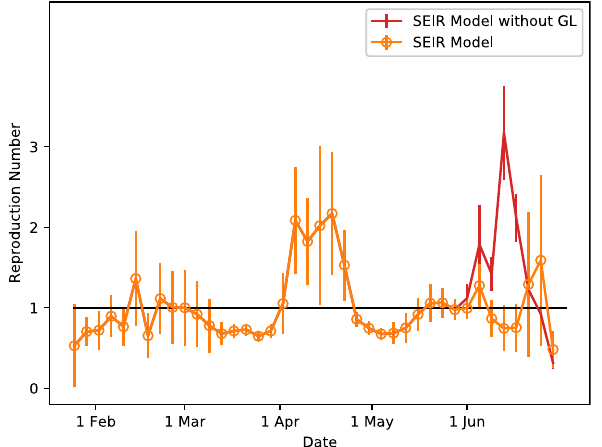
Figure 4. The dynamical evolution of the reproduction number R e derived from the SEIR multiplex model with and without Gradual Lifting (GL) measures. Note that the two very small waves of COVID-19 transmission at 14 Feb 2020 and 22 Feb 2020 discussed in the main text (see Fig. 2) are slightly shifted in this plot due to the large statistical fluctuations.